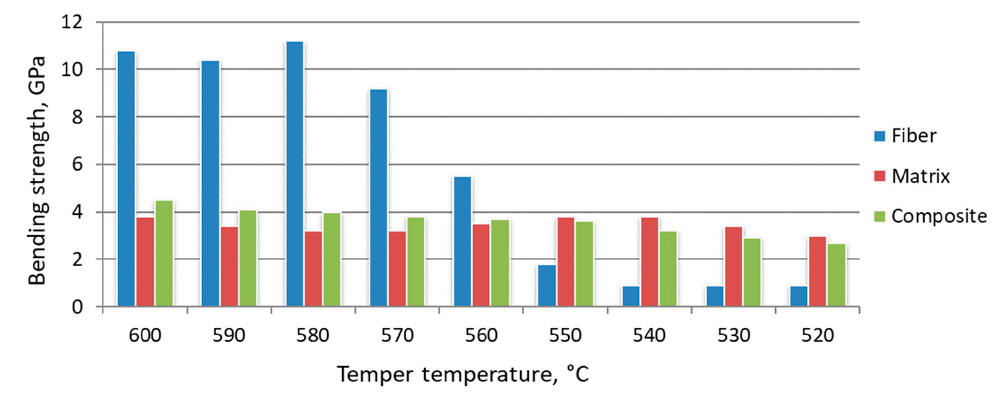
Figure 18. Effect of tempering temperature on the characteristics of composite material based on W6Mo5Cr4V2 steel, hardened at 1290 °C.